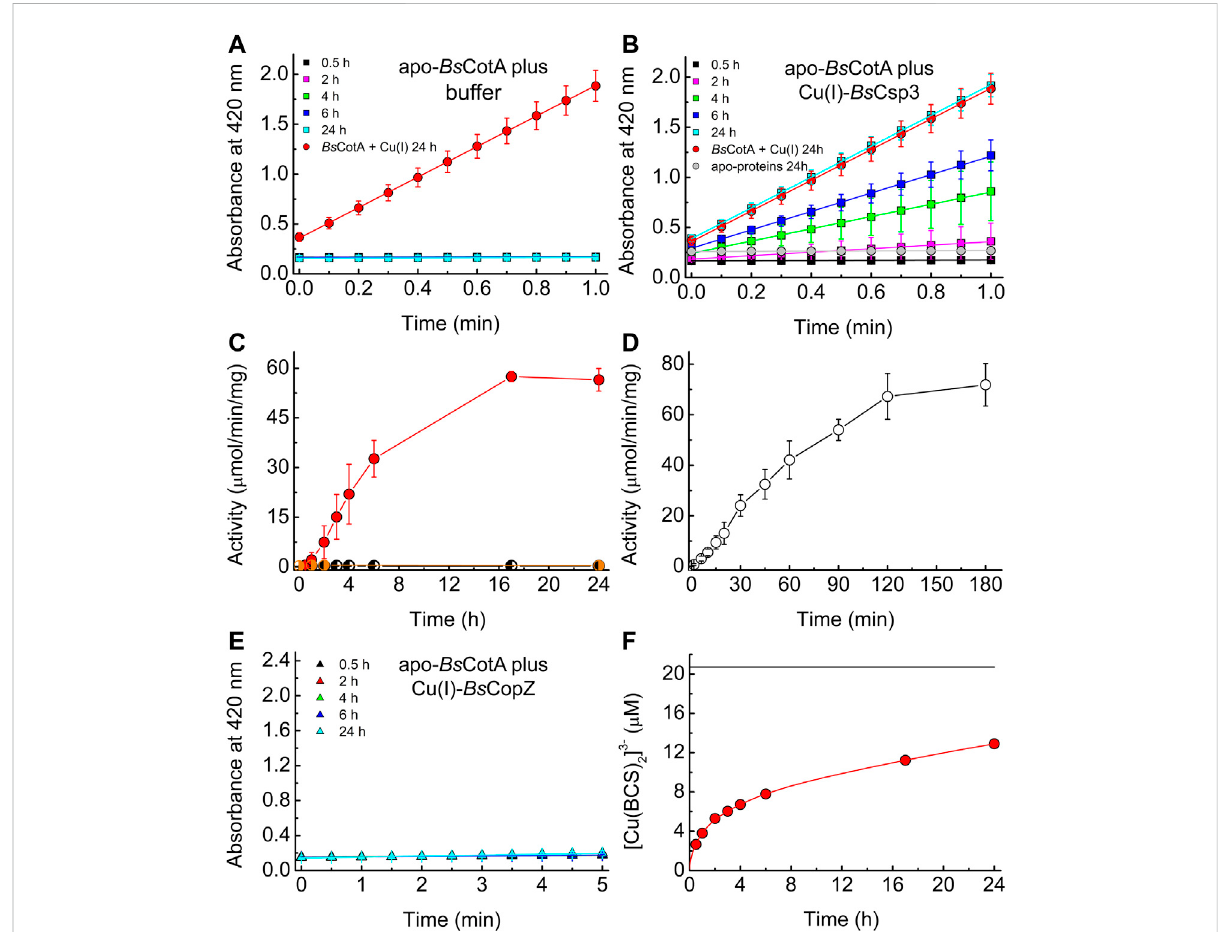
FIGURE 3 Theactivationofapo- Bs CotA byCu(I)- Bs Csp3andassociativeCu(I)transfer.Plotsofabsorbanceat420 nmagainsttimefor thereactionwith2.4 mM ABTS (at 37 ° C) of mixtures of apo- Bs CotA incubated with buffer (A) and Cu(I)- Bs Csp3 (B) for up to 24 h. Also shown is the data obtained when apo- Bs CotA was incubated with Cu(I) (red circles in A and B) and apo- Bs Csp3 (grey circles in B) for 24 h. Mixtures were incubated under anaerobic conditions(apartfromthereactionwithapo- Bs Csp3)in20 mM4-(2-hydroxyethyl)piperazine-1-ethanesulfonicacid(HEPES)pH7.5plus200 mMNaCl (the buffer used in A ), and Bs CotA activity was measured in 100 mM citrate-phosphate buffer pH 4.0. (C) Plots of activity against incubation time of apo- Bs CotAplusbufferalone(half-blackcircles),Cu(I)- Bs Csp3(redcircles),andapo- Bs Csp3(half-greycircles)forupto24 h(verysimilarvaluestothoseat24 h weremeasuredat48 hforbufferandCu(I)- Bs Csp3).In (D) areactivitydataobtainedwhenapo- Bs CotAwiththeCys229-Cys322disul fi debondreduced,was mixed with Cu(I)- Bs Csp3 for up to 180 min. (E) Plots of absorbance at 420 nm against time for the reaction with 2.4 mM ABTS (at 37 ° C) of apo- Bs CotA incubated with Cu(I)- Bs CopZ for up to 24 h (there was also no sign of activity after 48 h). All activity data are averages from three to six independent experiments(apartfromapo- Bs CotAplusapo- Bs Csp3)witherrorbarsshowingstandarddeviations. (F) Aplotof[Cu(BCS) 2 ] 3- concentrationagainsttimefor Bs Csp3 (1.08 µM) plus 18.0 equivalents of Cu(I) mixed with 2.5 mM BCS (red line) carried out in the same buffer as that used in (A – E) under